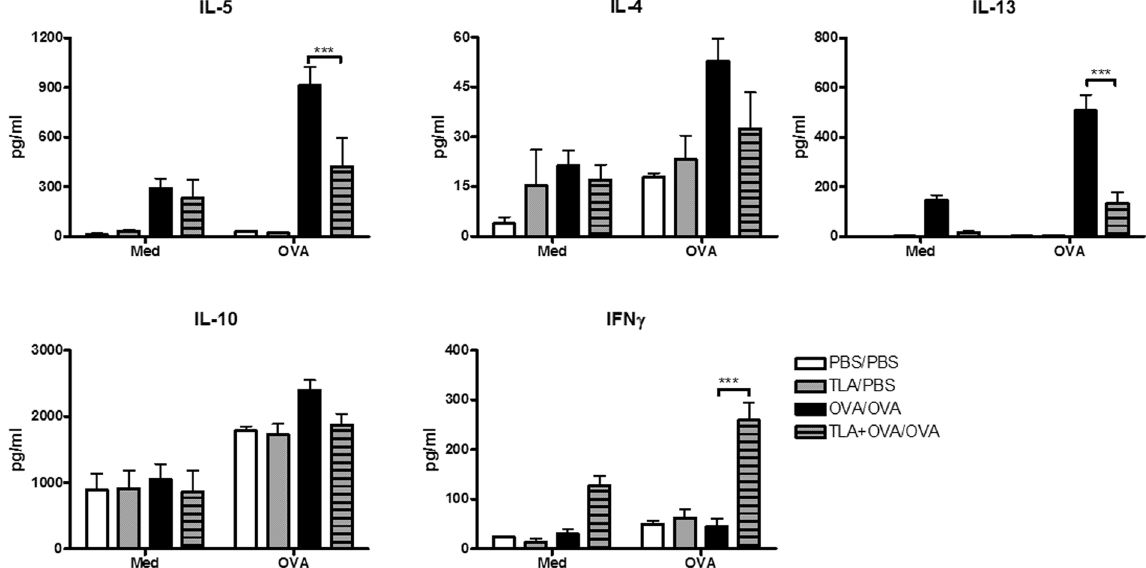
Figure 4. Effect of TLA on the production of cytokines in lungs. Mice were treated as indicated in Fig. 3a. Lungs were collected on day 25 and single cell suspensions (5 × 10 6 cells/ml) were cultured in the presence of medium (Med) or 50 µ g/ml OVA for 72 h. Levels of cytokines in culture supernatants were assessed by ELISA. Data are representative of three experiments (n = 5 mice per group). Results of ANOVA test: *** P < 0.001.